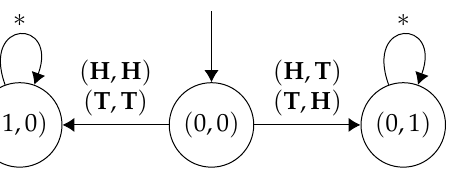
Figure 6. CORE ( G 2 ) (cid:42) NE ( G 2 ) . The asterisks * are wildcards—they match any action which isn’t explicitly detailed on the